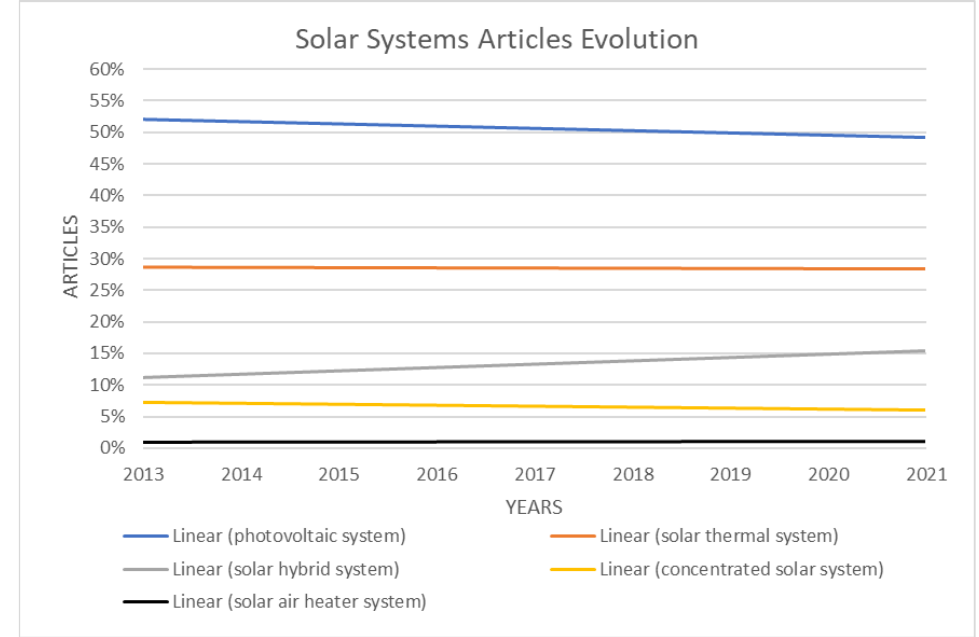
Figure 2. Articles evolution for solar systems, period of 2011 – 2021.